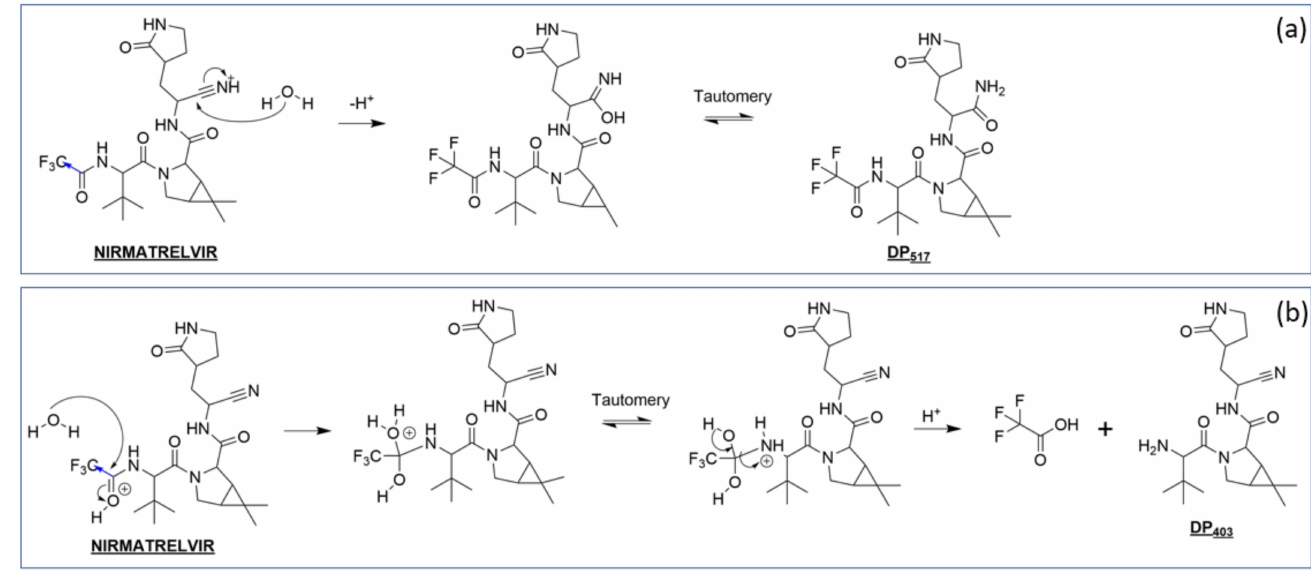
Figure 7. Proposed nirmatrelvir’s degradation pathways under acidic conditions leading to the formation of DP 517 ( a ) and DP 403 ( b